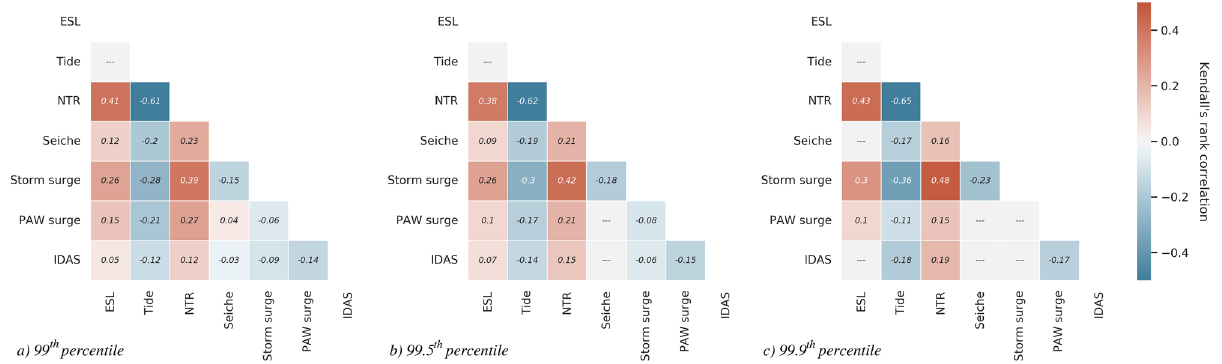
Figure 4. Kendall’s rank correlations among the different drivers for the 99th ( a ), 99.5th ( b ) and 99.9th ( c ) ESL percentiles. Only values statistically significant at the 0.05 level are